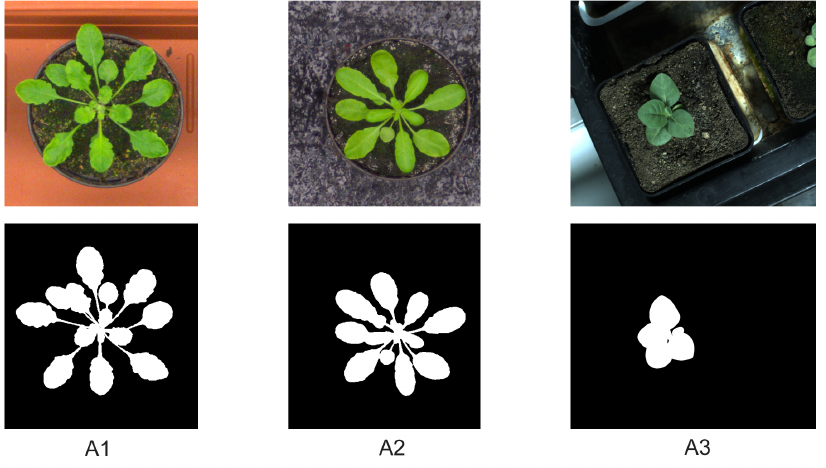
Figure 2. Examples of original (top row) and binary segmented (bottom row) top-view images of arabidopsis ( A1 , A2 ), and tobacco ( A3 ) plants from